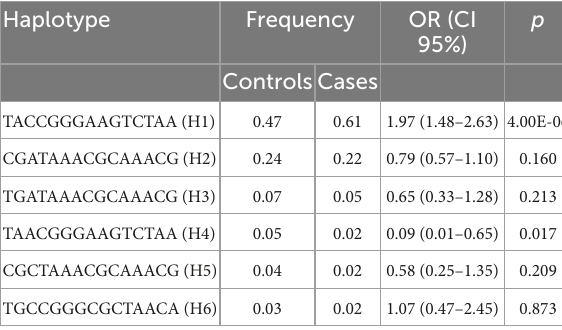
TABLE 3 Haplotype frequencies in a case-control